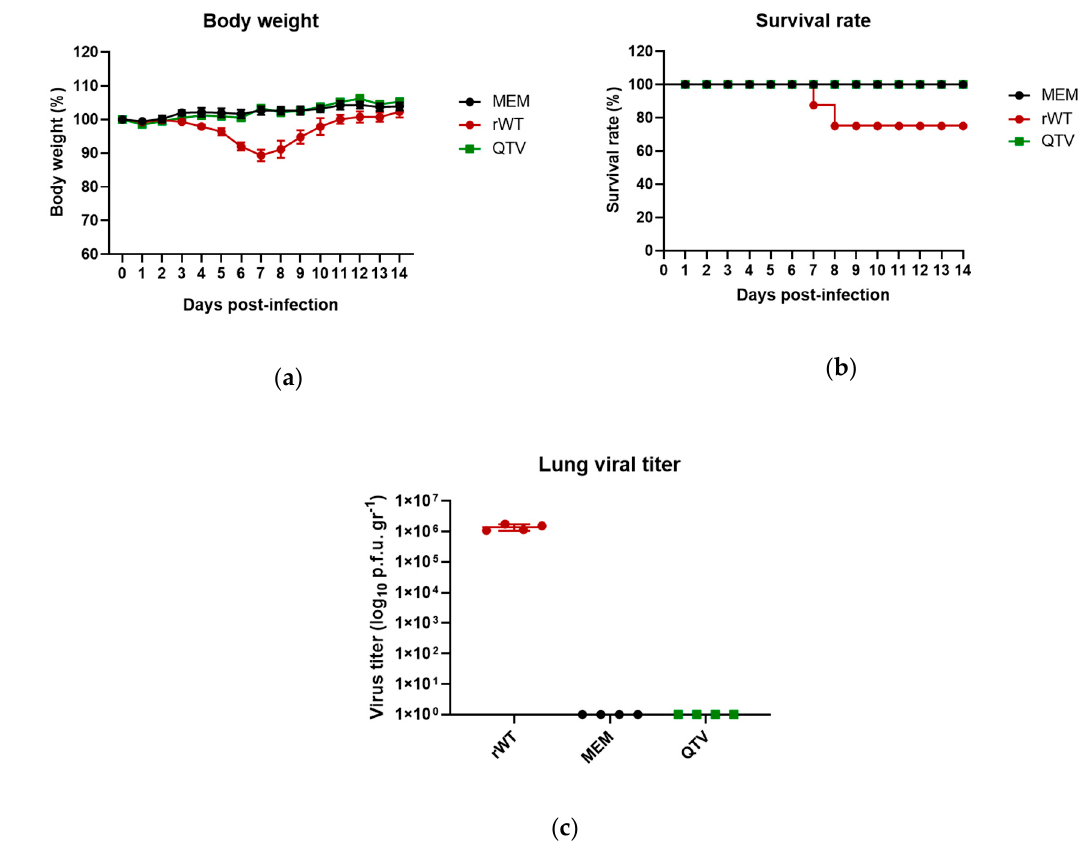
Figure 3. The body weight, survival rate, and lung viral titration of mice infected with the rWT virus and the reassortant mutant QTV virus. Male and female BALB / c mice ( n = 12 per group, equal males and females) were intranasally infected with either MEM (control), the rWT virus, or the reassortant mutant QTV virus at a single dose of 1 × 10 3 PFU. The mice were monitored daily, with any mouse reaching a humane intervention point to be humanely euthanized and their lung samples harvested. ( a ) The body weights. ( b ) The survival rate. ( c ) The viral titration of homogenized lung samples at 3 d.p.i. by plaque assay. The samples were analyzed in duplicate. Viral titres are expressed as PFU per gram (PFU / gr). The data is shown as the mean ± the standard deviation. The dots correspond to the values obtained from individual mouse samples.